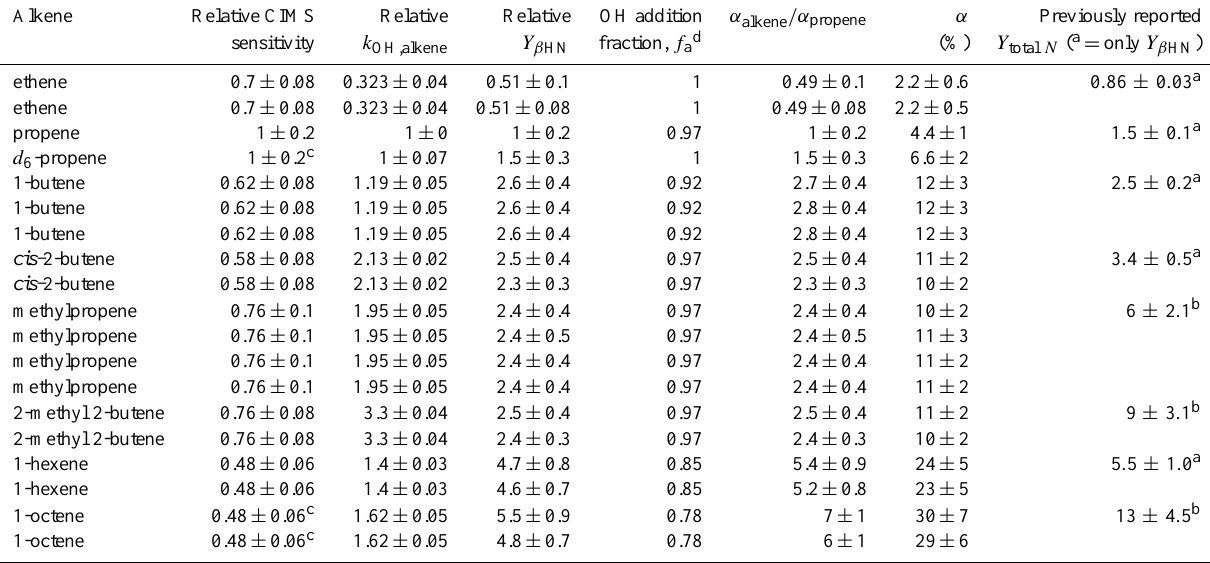
Table 4. β HN sensitivities, OH rates, f a , relative Y β HN , α alkene /α propene and branching ratios to form β -hydroxy nitrates (HN) at 293K and